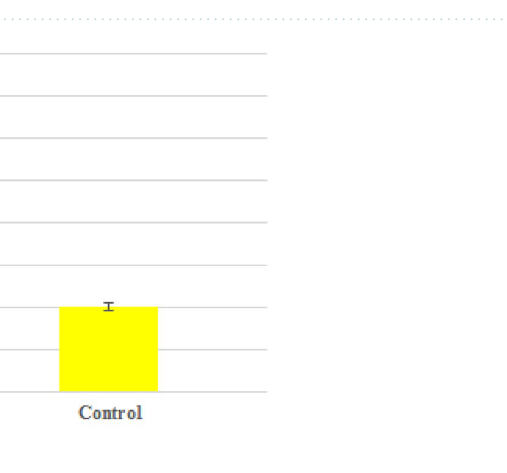
Figure 8. Relative expression of the ( a ) BAX , ( b ) Bcl-2 , and ( c ) CASP8 gene in Bi 2 O 3 /Gln-TSC NPs treated cells. (Data are normalized to untreated cells and reported as mean ± SD. Asterisks (*) indicate a significant difference with the control group (* = P < 0.05, ** = P < 0.01, *** = P < 0.001).